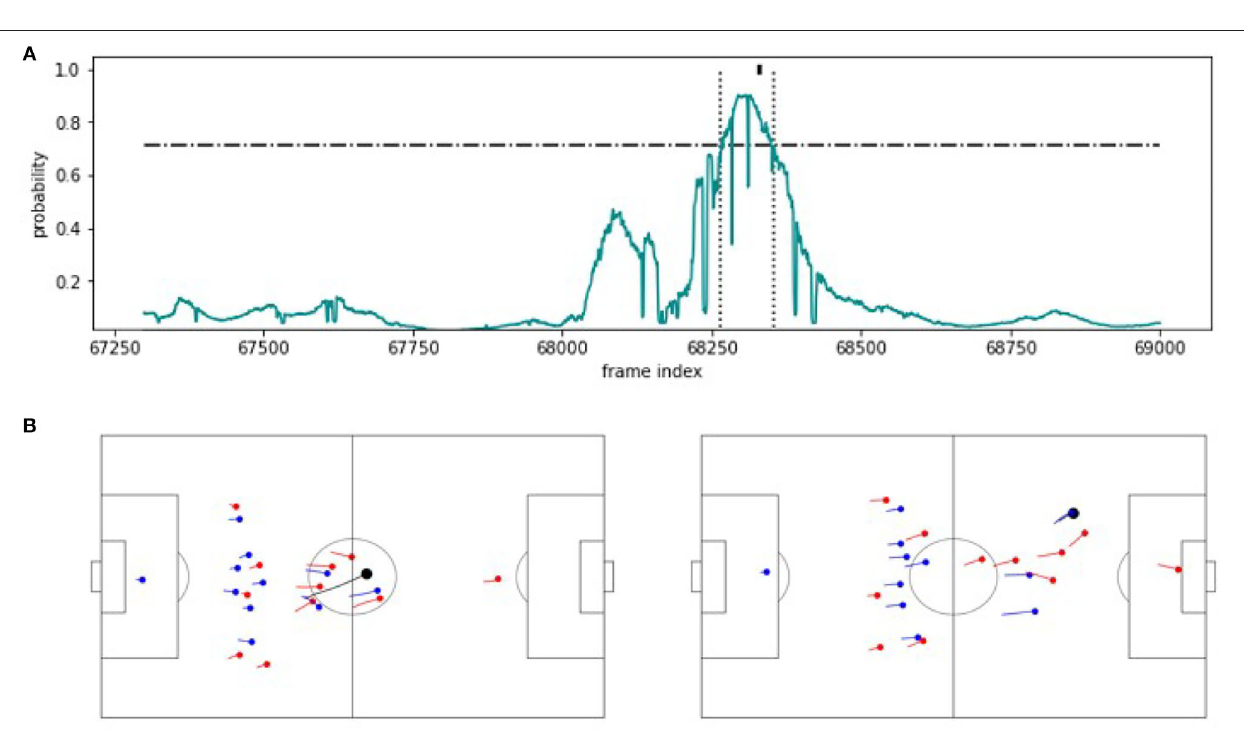
FIGURE 5 | TP example. (A) Predicted probability values for an approximately 70 s excerpt from the validation game. The horizontal line indicates the threshold applied on the probabilities to recognize a counterattack. The vertical lines mark the beginning and the end of the extracted sequence. The mark at the probability value 1 indicates the counterattack annotation. (B) The corresponding snapshot visualizations for the beginning (left) and the end (right) of the detected